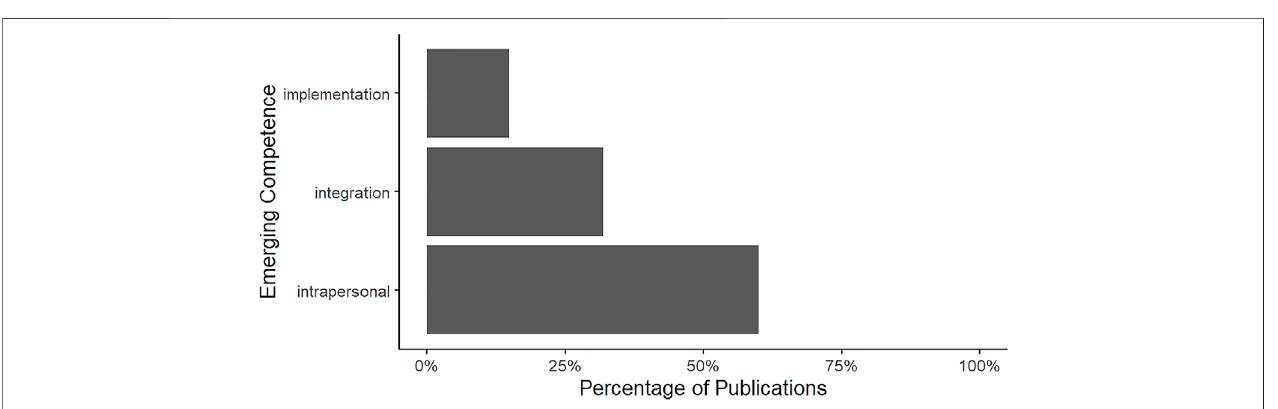
FIGURE 5 | Percentage of sampled publications ( n (cid:1) 272) that can be mapped onto the three emerging competencies (1997 – 2020).